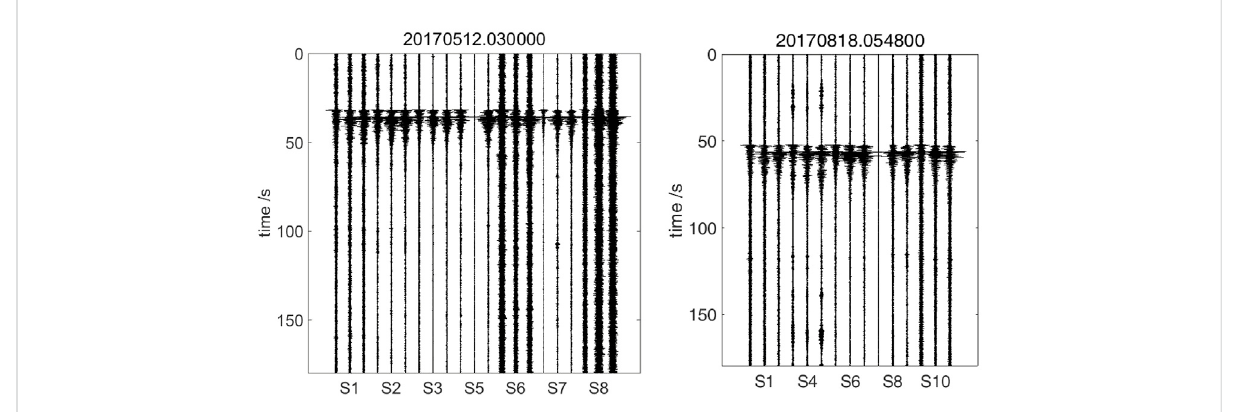
FIGURE 10 Two examples of signals similar to the fi rst part of the paired signals but without the second part having the window length of 180 s. The title of each waveform is the UTC time for the beginning time of the record. The horizontal coordinate is the station number and three channels for each station are